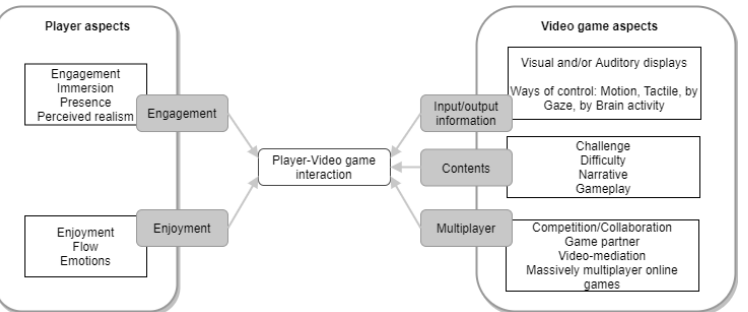
Figure 2. Aspects (gray) of player–video game interaction and their respective concepts (white), by Caroux et al. [29].